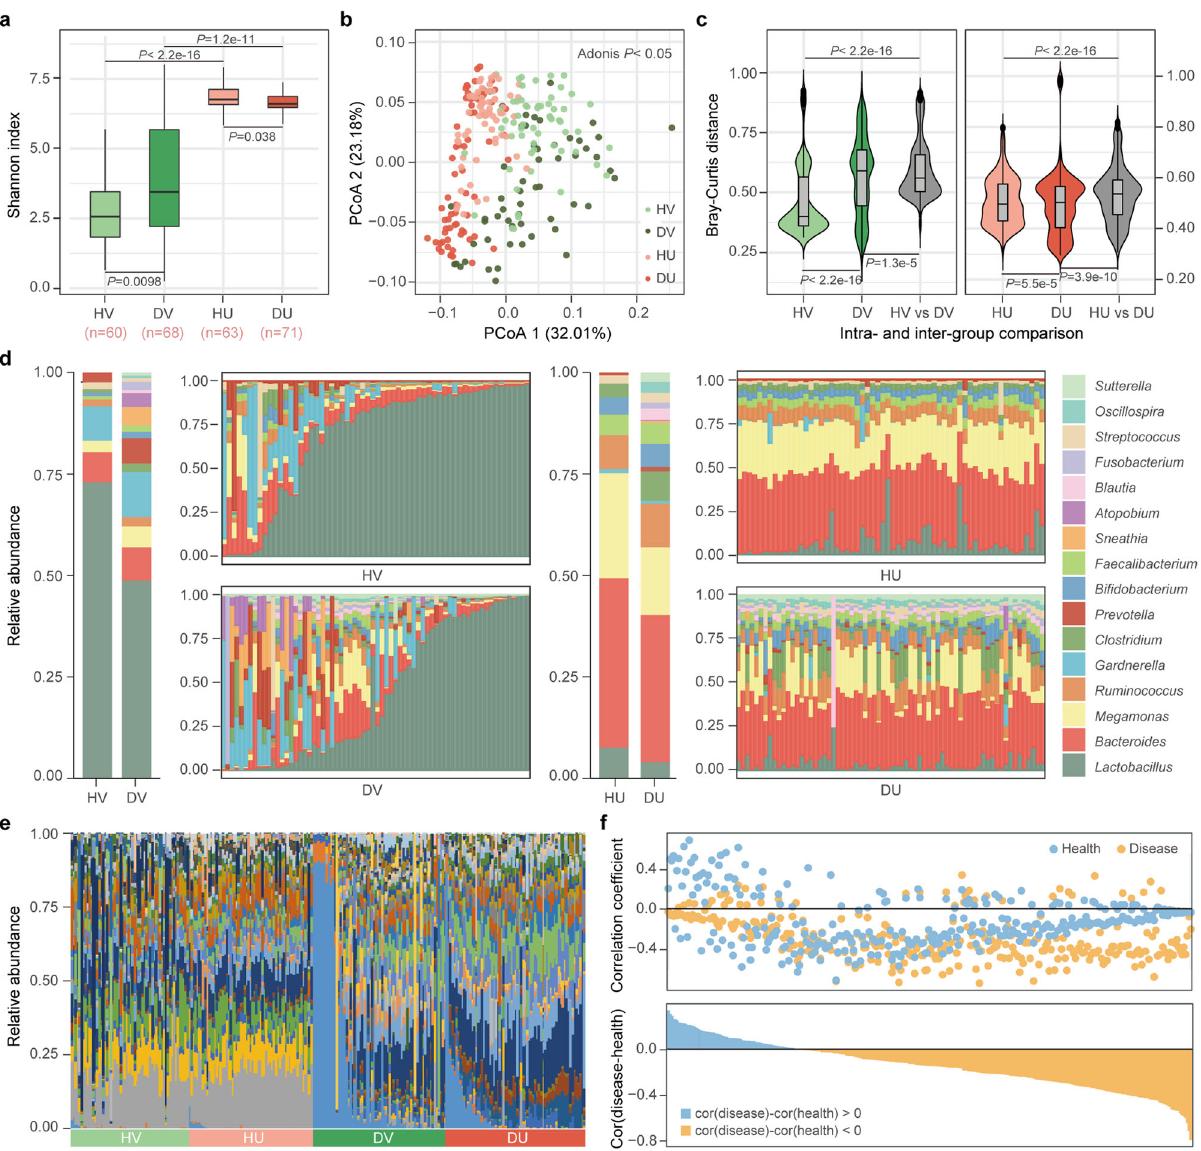
Fig. 2 The uterine and vaginal microbiome of healthy women and women with chronic endometritis. HV, DV, HU, and DU represent healthy vagina, endometritis vagina, healthy uterus, and endometritis uterus, respectively. a Microbial diversity of the uterine and vaginal microbiome in women with different health statuses. Box-plot elements are de fi ned as: center line, median; box limits, upper and lower quartiles; whiskers, 1.5× interquartile range; points, outliers. P values were determined by two-tailed Wilcoxon test. b Principal coordinate analysis (PCoA) of the uterine and vaginal microbiome of different health statuses. The signi fi cance of separation of two clusters was measured with the Adonis test ( P < 0.05). c The Bray-Curtis (BC) distance of the microbial communities among individuals within the same group and between different groups. The violin with box plot shows the median and interquartile range, and the width of the violin represents the density distribution of the BC distance values. P values were determined by two-tailed Wilcoxon test. d The relative abundance of the dominant genera in the uterine and vaginal microbiome of different health statuses. The two bars on the left show the average relative abundance of each group. e The relative abundances of discriminatory bacteria enriched in women with chronic endometritis. Linear discriminant analysis (LDA) effect size (LEfSe) analysis was performed to identify discriminatory bacteria, with an absolute value of log LDA score >3.0. f The co-occurrence of the same bacteria between the uterine and vaginal microbiome. In the top panel, the correlation coef fi cient of each OTU (each point) between the uterine and vaginal microbiome was calculated in women with (Disease group, yellow point) and without (Health group, blue point) chronic endometritis, respectively. In the bottom panel, the difference in the correlation coef fi cient of each OTU between the Disease group and the Health group is shown in blue and yellow same genus between the uterine and vaginal microbiome was analyze the co-occurrence relationship between the same and consistent in the control and endometritis groups despite the different bacterial taxa across body sites (Supplementary Fig. 4c). differences in the strength of the correlation (the pies on the two Only the different bacterial genera from different body sites (the green dotted lines), which was consistent with the analysis results pies on both sides of the blue dotted line) were involved in at the OTU level. Accordingly, the co-occurrence of the same distinct co-occurrence relationships under different health genus across body sites or different genera at the same site was statuses. In contrast, the positive or negative correlation of the